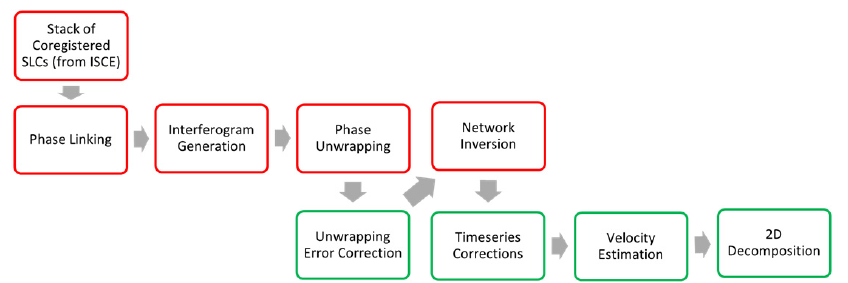
Figure 3. Simplified InSAR workflow. Red boxes denote steps performed by MiaplPy and green boxes denote steps performed by MintPy.